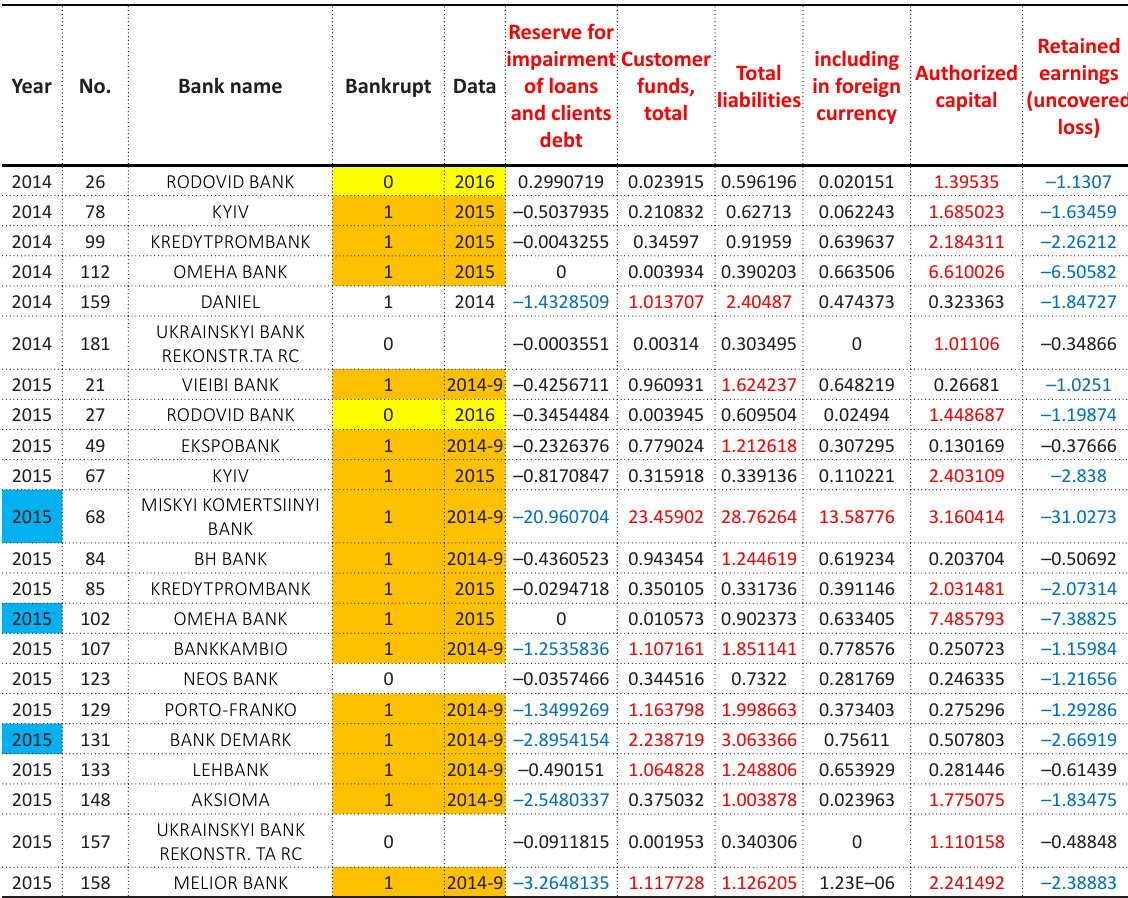
Table 2. Anomalous values of balance sheet ratios of Ukrainian commercial banks in 2014–2015